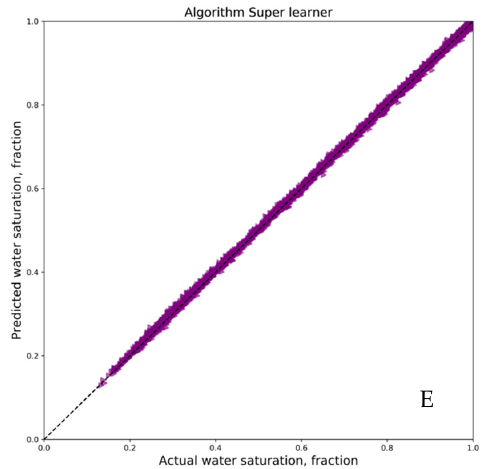
Figure 10. Cross plot for water saturation prediction results by different algorithms for dataset B. Cross-plots are representing target values vs. the predicted values. Here, PEF log has not been used as an input parameter and it is observed that super leaner still is generating the best results, A) XGBoost, B) LightGBM, C) Adaboost, D) Catboost and E) Super-lerner. Table 4. Evaluation metrics summary for dataset B where PEF log is kept out of the analysis/predictions.